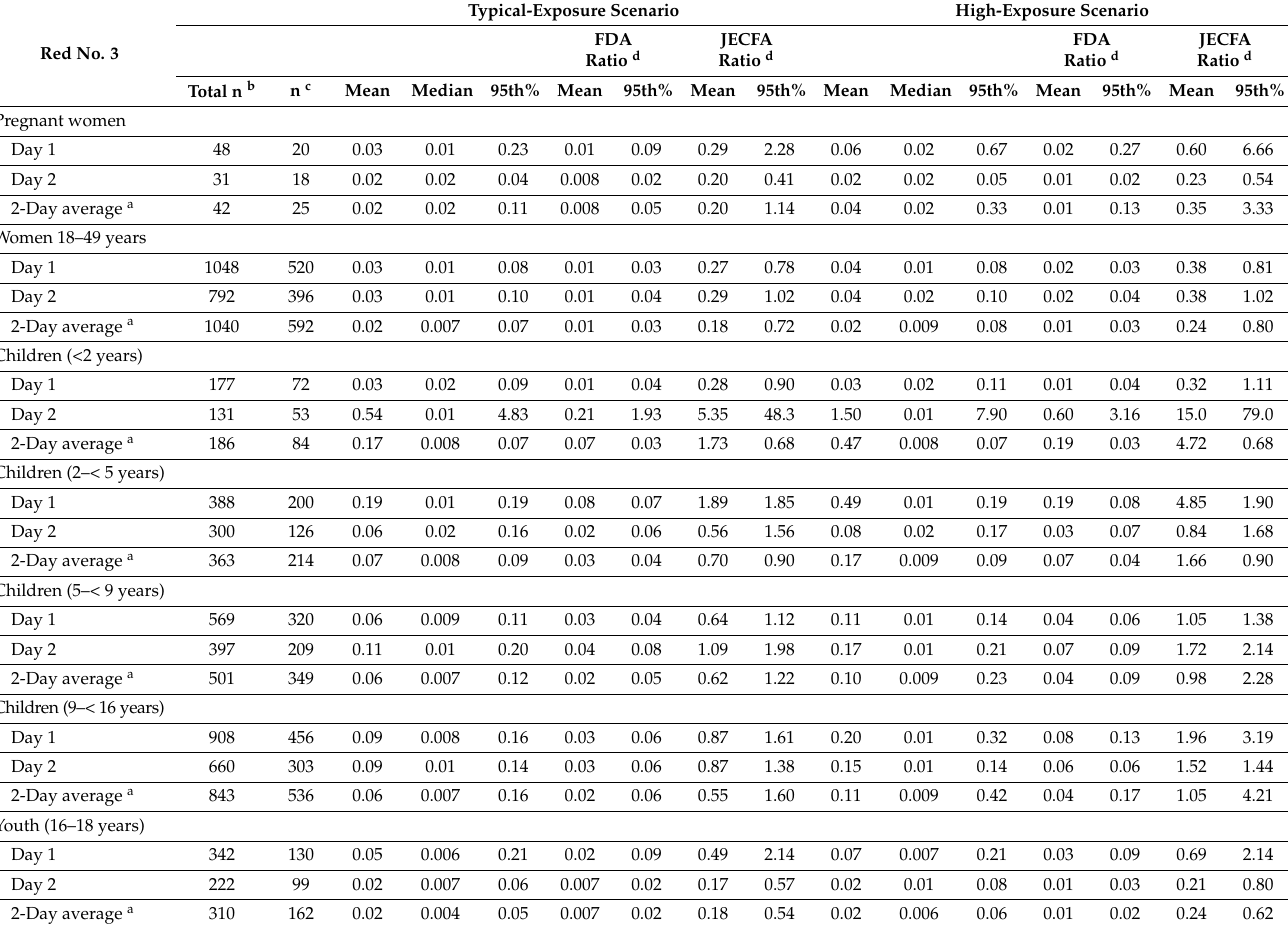
Table 3. Single-day and two-day average FD&C Red No. 3 exposure estimates (mg/kg/day) and hazard ratios under typical- and high-exposure scenarios, among pregnant women, women of childbearing age, and children of various ages who consumed at least one food containing Red No.